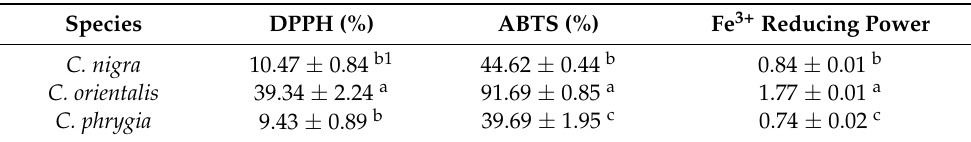
Table 1. DPPH radical scavenging activity (%), ABTS radical scavenging activity (%) and Fe 3+ reducing power of three Centaurea species. The data represent the mean ± standard deviation of three